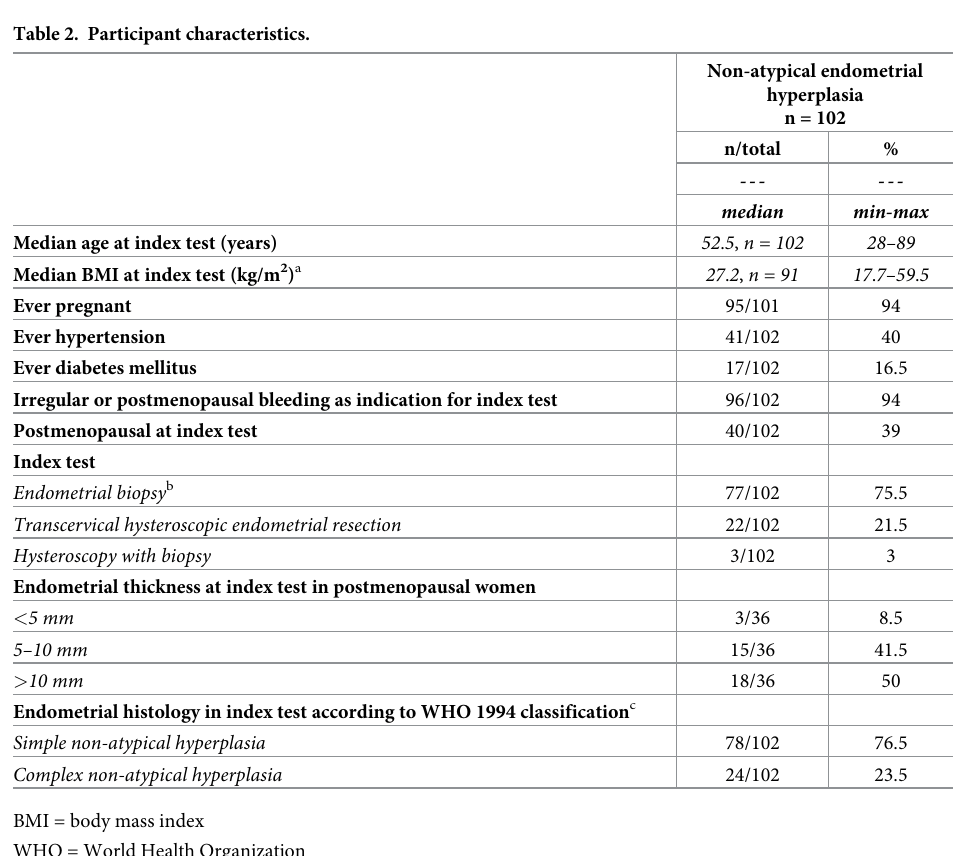
Table 2. Participant